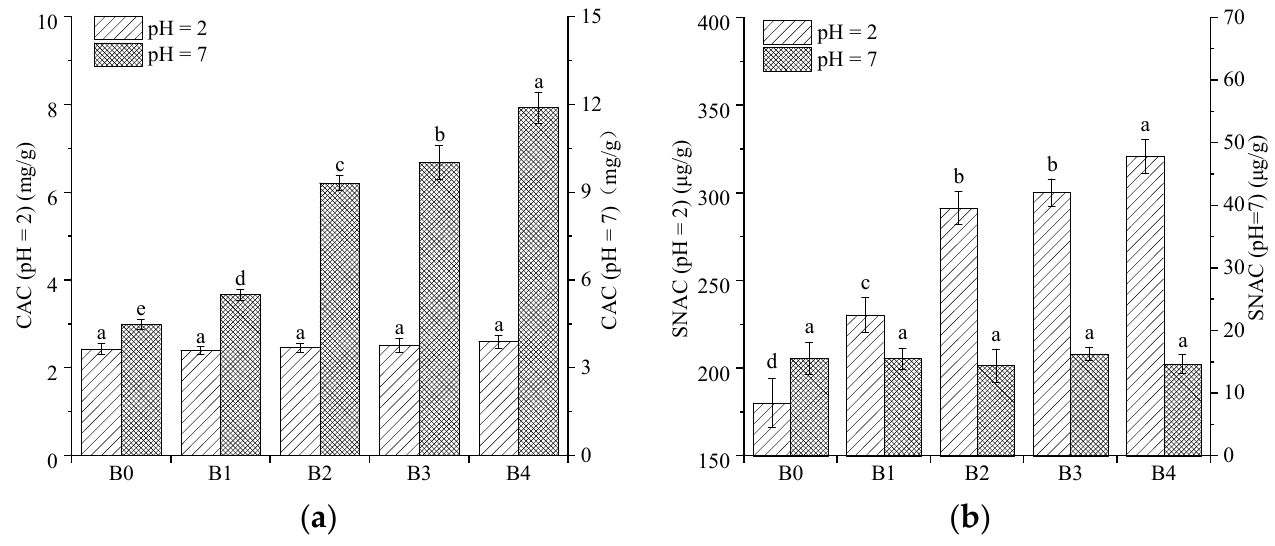
Figure 8. Cholesterol-absorption capacity (CAC, ( a )) and sodium nitrite-absorption capacity (SNAC,